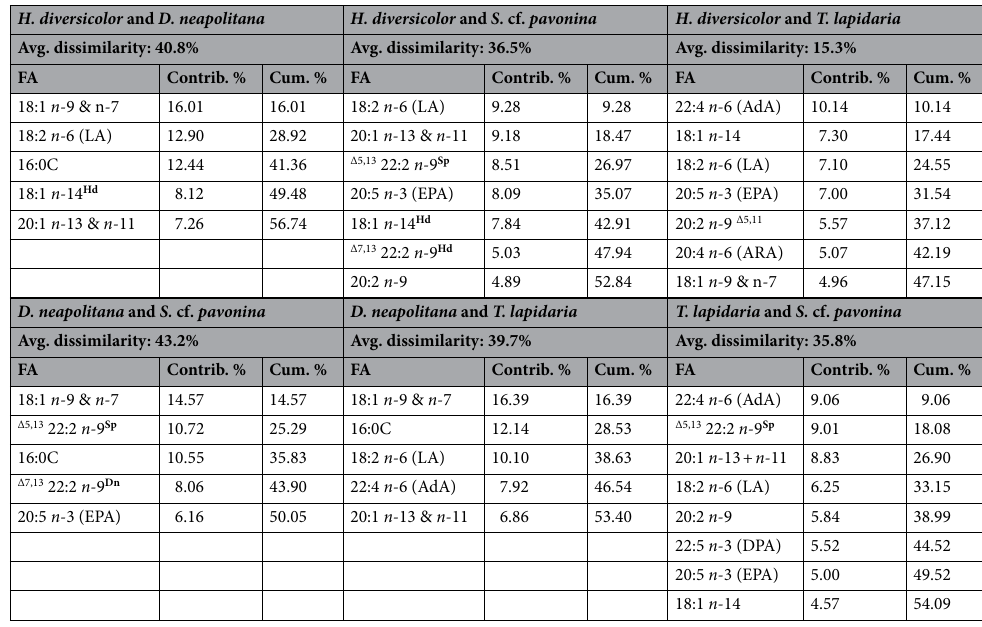
Table 3. SIMPER overall average dissimilarities (%) between fatty acid (FA) profile of different polychaete species cultured in sand beds using an open integrated multi-trophic aquaculture (IMTA) approach. The FA identified with bold superscript: Hd, Dn, Tl and Sp were only identified in the species Hediste diversicolor , Diopatra neapolitana , Terebella lapidaria and Sabella cf. pavonina . respectively. AdA adrenic acid, ARA arachidonic acid, DPA docosapentaenoic acid, EPA eicosapentaenoic acid, LA linoleic